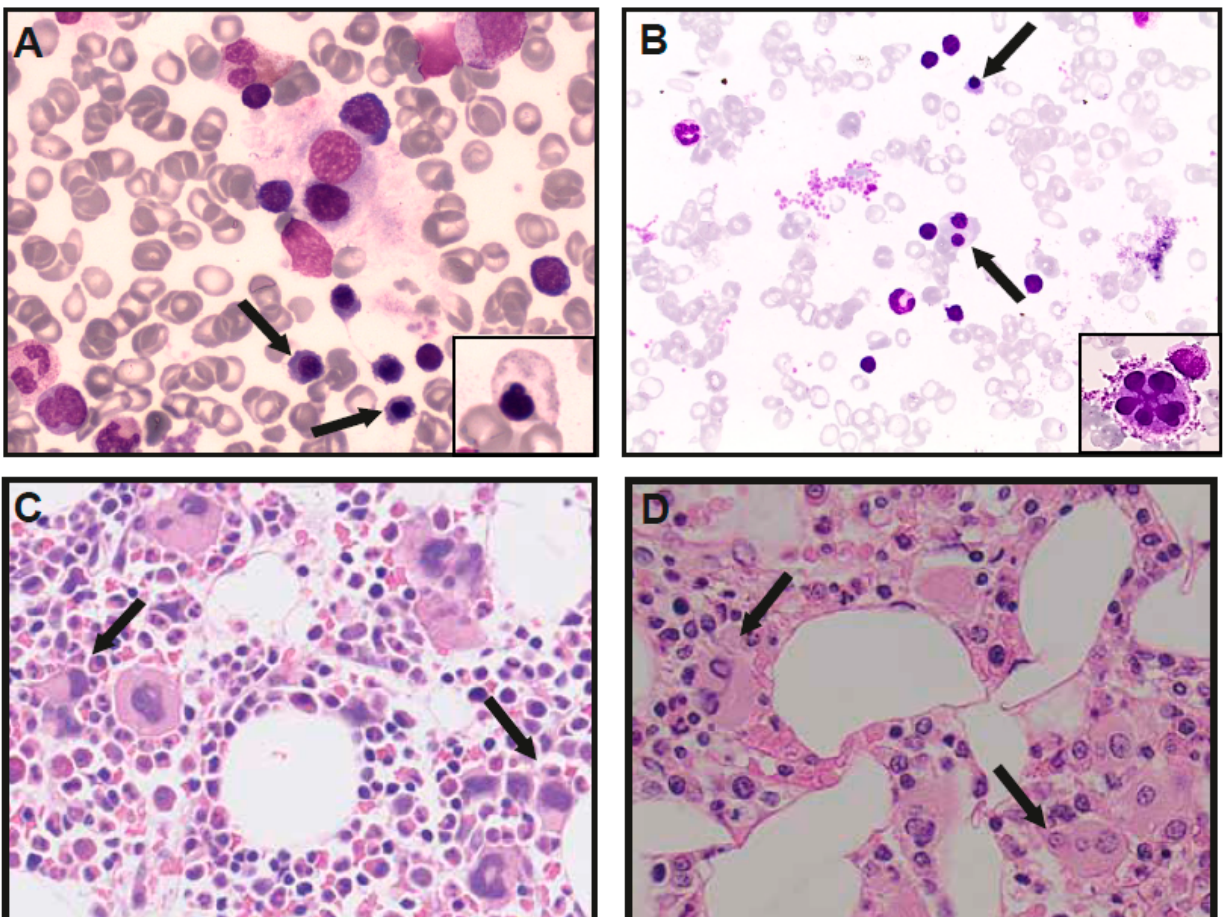
Figure 2. Bone marrow analysis of GATA-1 DBA patients. Bone marrow aspirates demonstrating dysplastic erythroid precursor cells (arrows), and aberrant shapes (small panel) in patient 1 ( A ) and dyserytropoiesis (arrows) and dysplastic megakaryocytes (small panel) in patient V-I ( B ). Trephine biopsies, demonstrating normocellular bone marrow with increased, dysplastic megakaryopoiesis (arrows) in patient 1 ( C ) and reduced cellularity and erythropoiesis with dysmegakaryopoiesis in patient V-I ( D ).